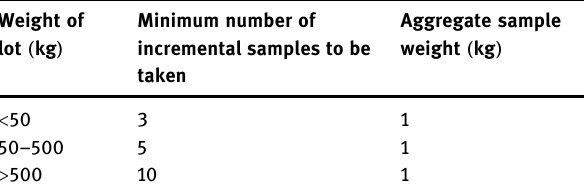
Table 4: Minimum number of incremental samples to be taken from the lot ( for solid samples